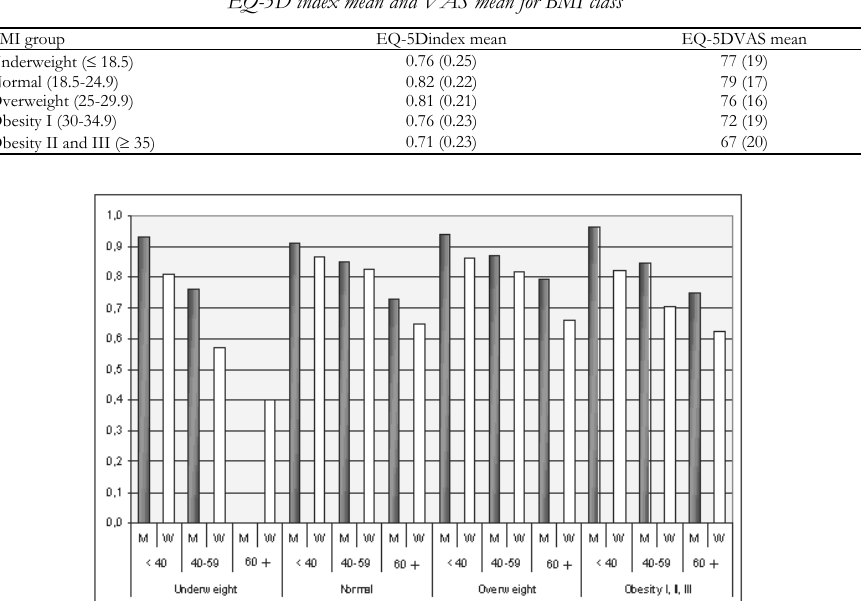
Figure 2 – Comparisons of EQ-5D index mean and gender, age groups and BMI groups